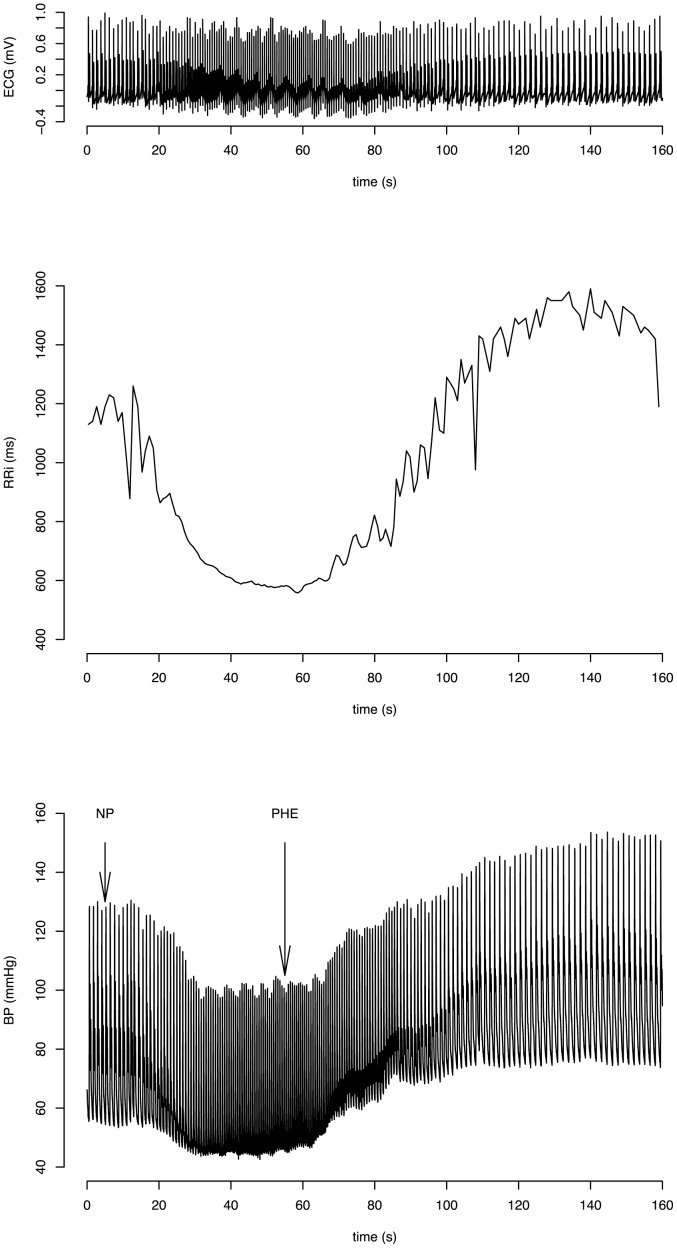
Modified Oxford baroreflex test.ECG, RR interval and blood pressure recording during the modified Oxford baroreflex test in a representative subject. Arrows indicate sodium nitroprusside (NP) and phenylephrine (PHE) bolus injections. Blood pressure fall is followed by a blood pressure rise in response to the bolus injections.